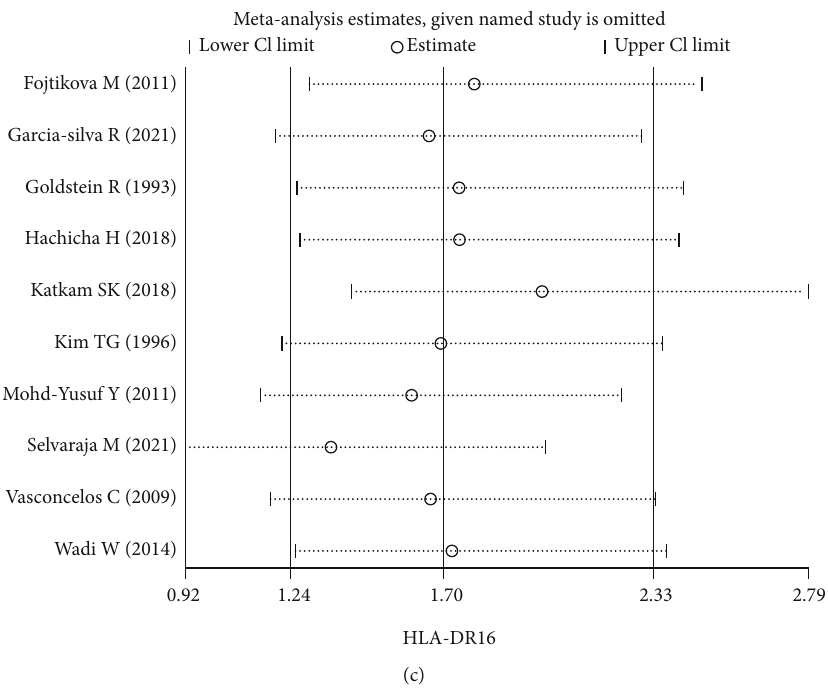
Figure 3: Sensitivity analysis of SLE risk associated with HLA-DR1 (a), HLA-DR13 (b), and HLA-DR16 (c)